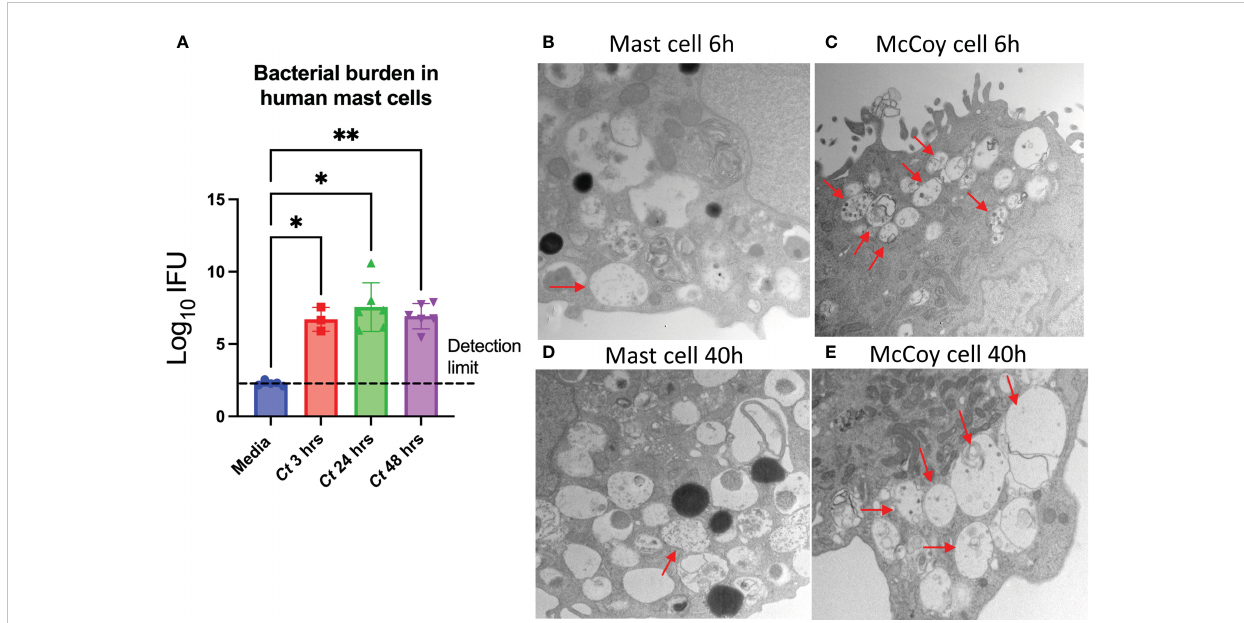
FIGURE 1 C trachomatis is taken up by human mast cells but does not effectively replicate. (A) CBMCs were treated with C trachomatis MOI = 1 and paired medium controls. Total genomic DNA was isolated from the cell pellets at 3, 24, and 48 h post-treatment, and bacterial content was measured by qPCR ampli fi cation of the chlamydial 16S gene. The data represent two independent experiments with n = 3 to 6 donors. * p < 0.05 and ** p < 0.01, as determined by Sidak ’ s multiple comparisons tests. (B – E) CBMCs were incubated with C trachomatis (MOI = 20), and McCoy cells were incubated with C trachomatis (MOI = 0.5). At 6 h (B, C) and 40 h (D , E) , Chlamydia inclusion bodies were visualized by transmission electron microscopy. Images are representative of duplicate samples prepared for each